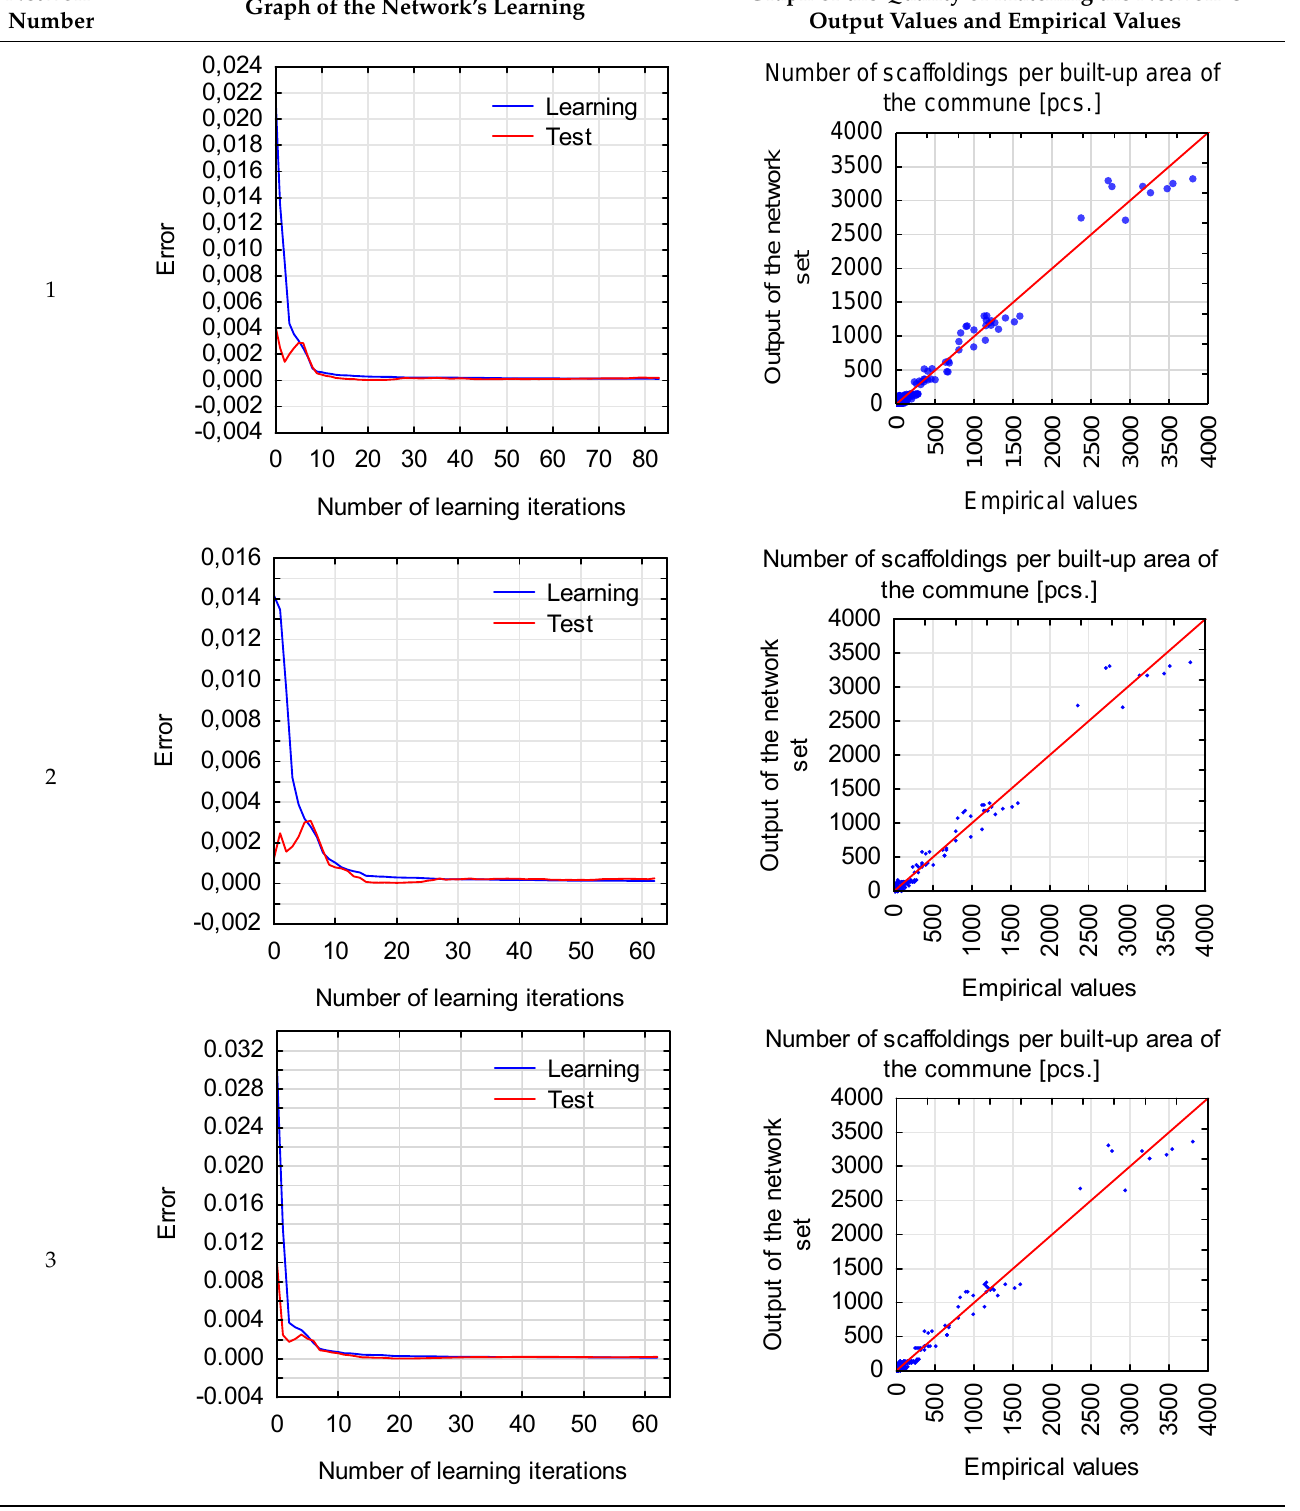
the commune [pcs.]